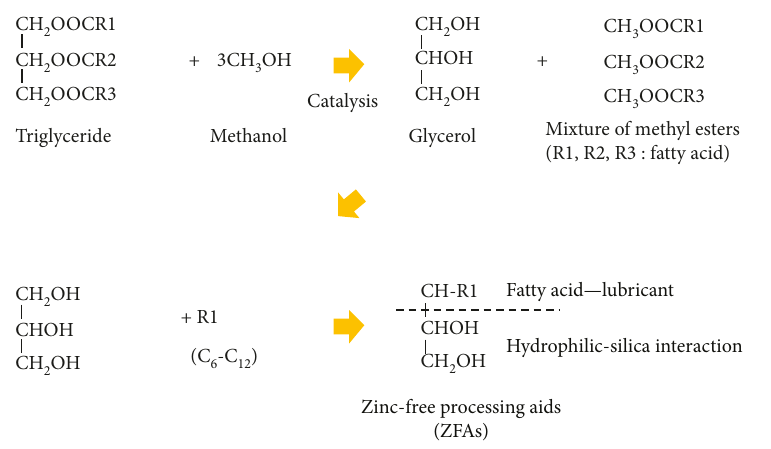
Figure 1: A schematic diagram showing the preparation of zinc-free processing aids (ZFAs).